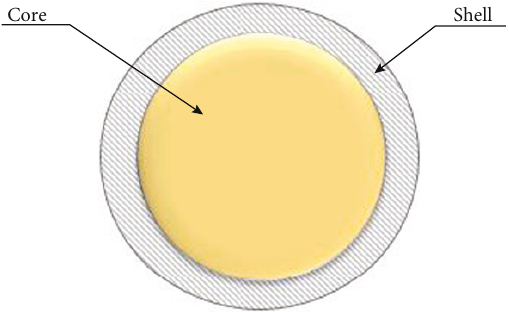
Figure 1: Illustration of a core-shell